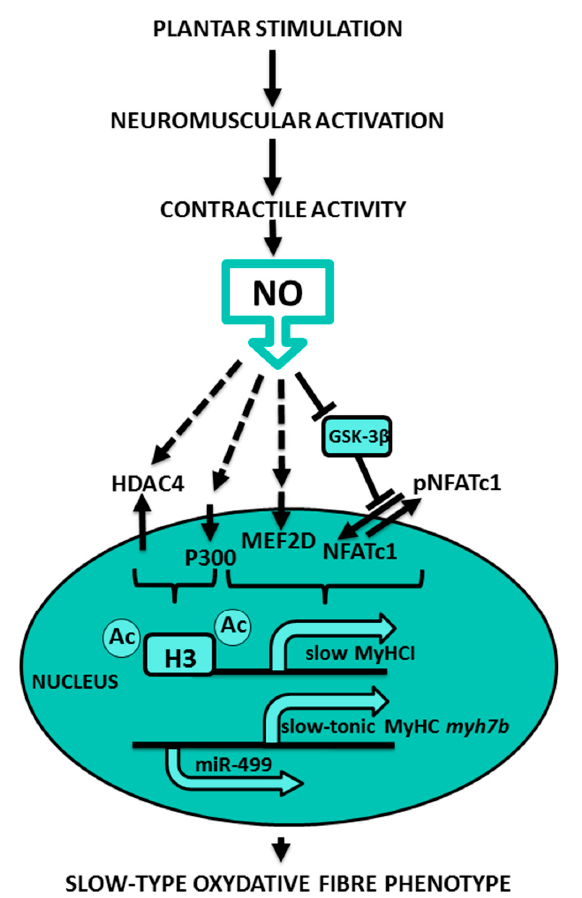
Figure 8. NO-dependent mechanisms of skeletal muscle fiber-type regulation during